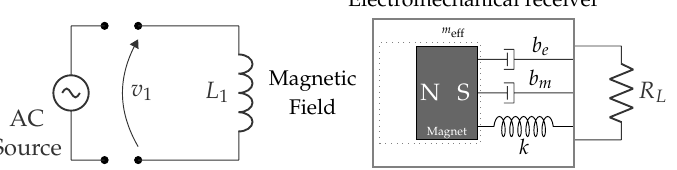
Figure 10. Electrodynamically coupled WPT system with electromechanical receiver [13].